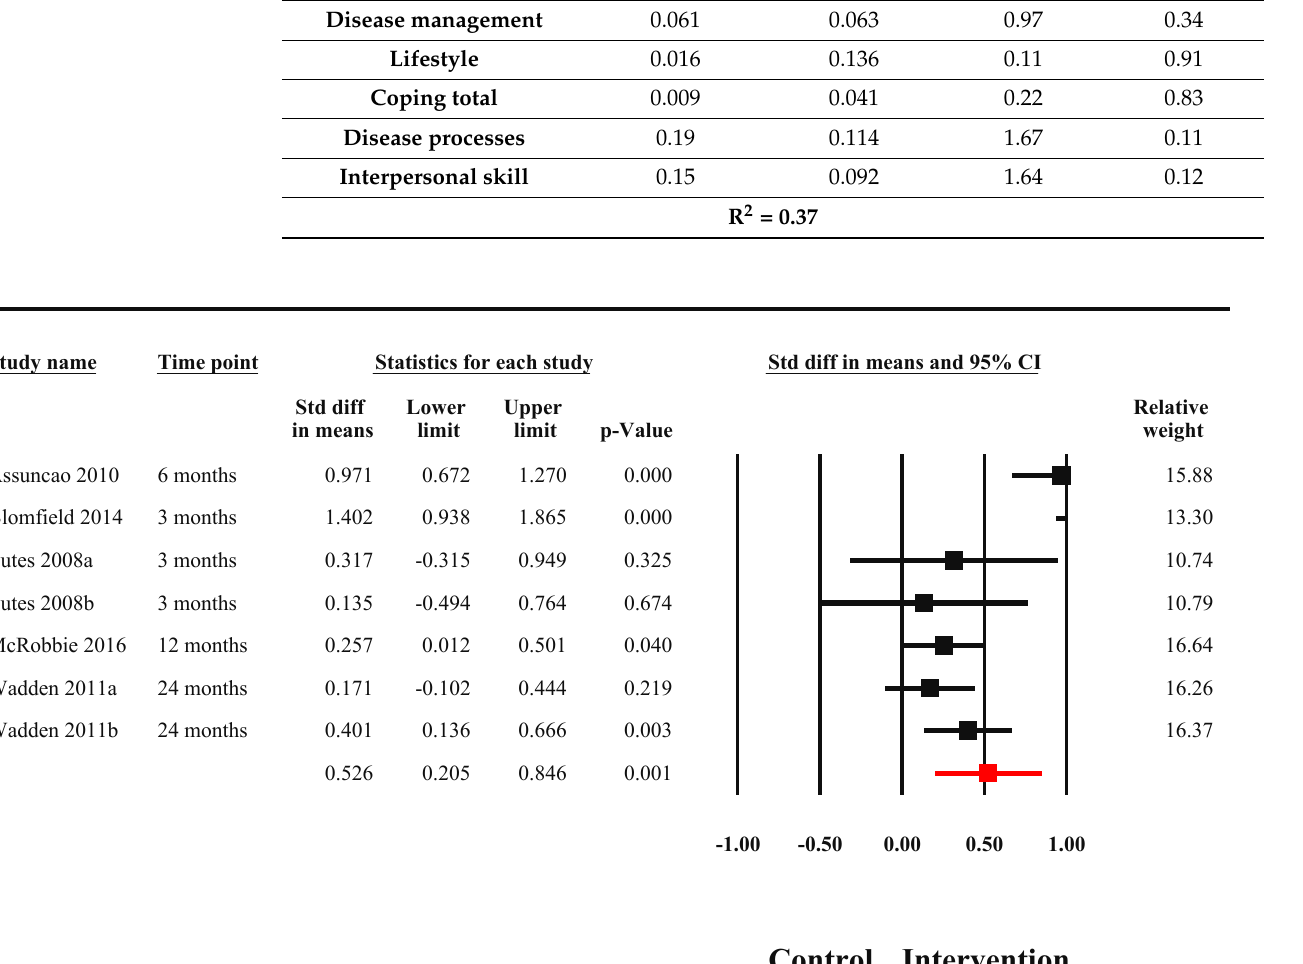
Figure 6. Effectiveness of TPE interventions in improving body weight among patients with obesity. The black blocks present point estimates and 95% confidence intervals for individual studies. The red block presents pooled effect size and associated 95% confidence intervals [25,39,55,64,66].